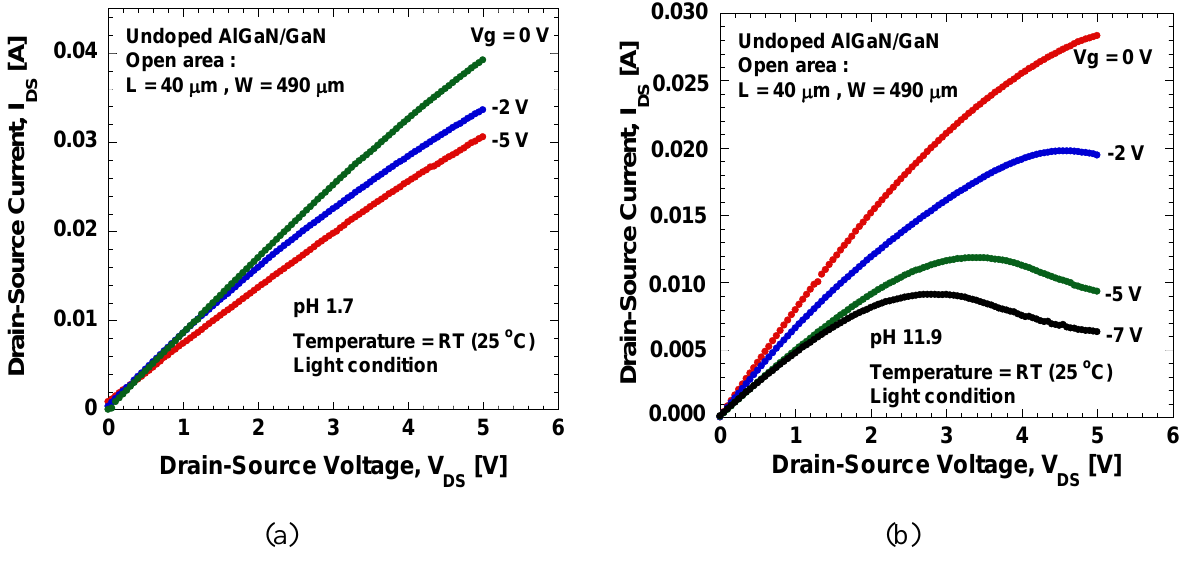
Figure 5. Typical I and (b) pH of